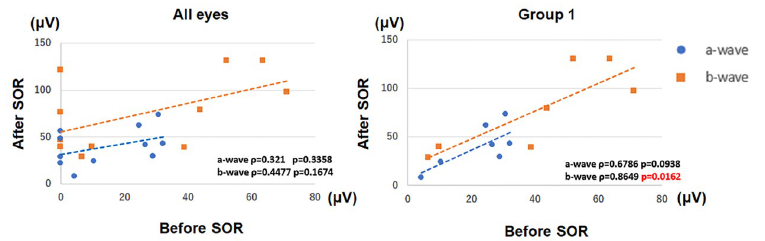
Fig 3. Amplitudes of the a- and b-waves before and after silicone oil (SO) removal. There was a significant positive correlation between the b-wave amplitudes before and after SO removal for the 7 eyes in Group 1 ( ρ = 0.8649, P = 0.0162). SOR, silicone oil removal; blue circle, a-wave; orange square,